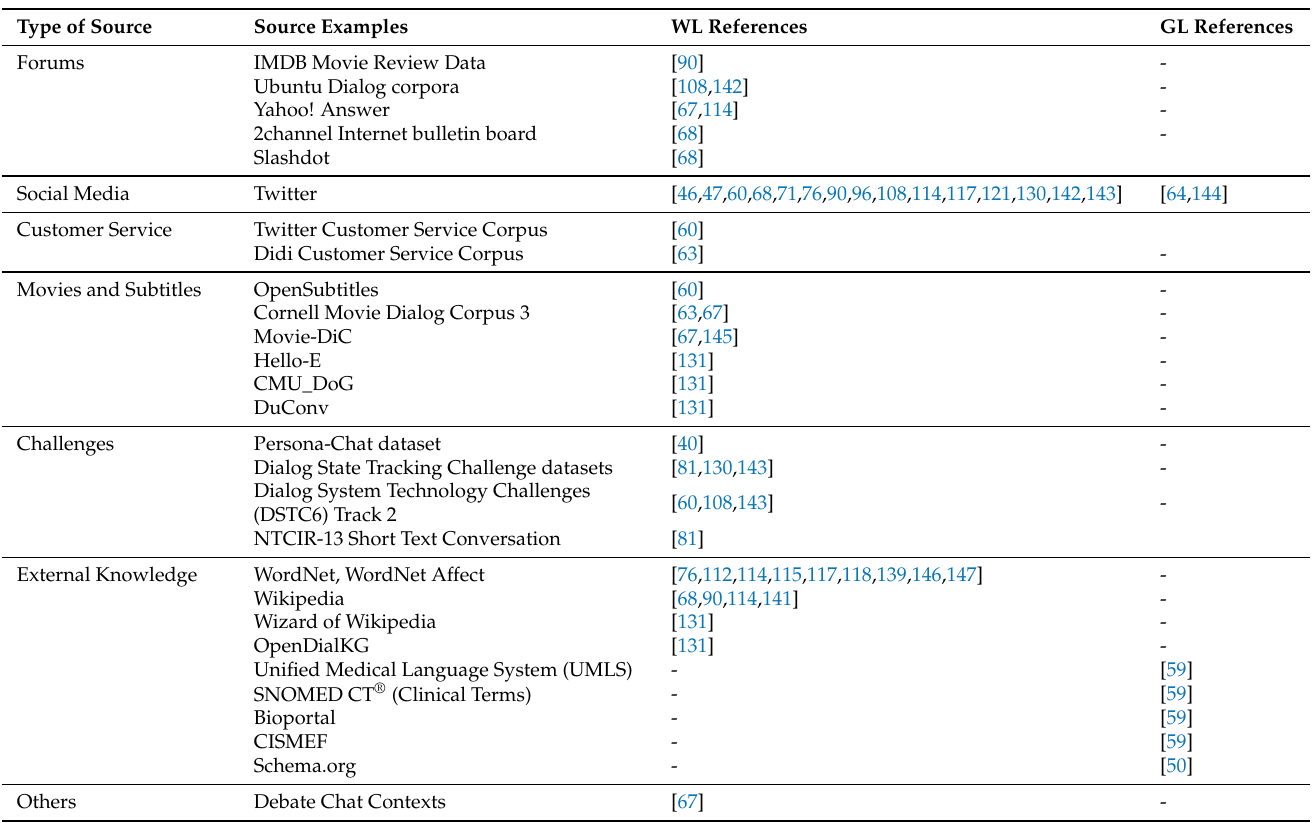
Table 7. Categories and examples of datasets mentioned in the selected pool of